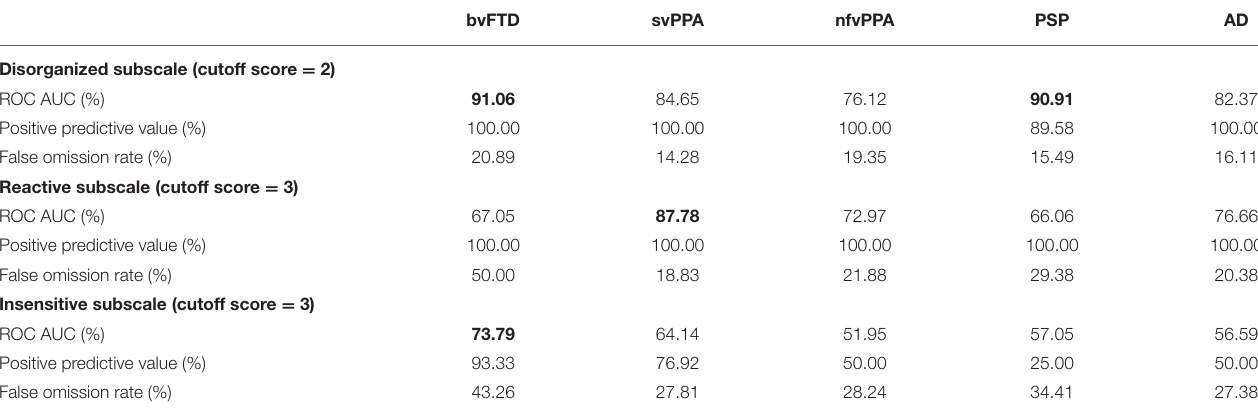
TABLE 3 | Subscale characteristics for each patient group vs. healthy older adults. bvFTD svPPA nfvPPA